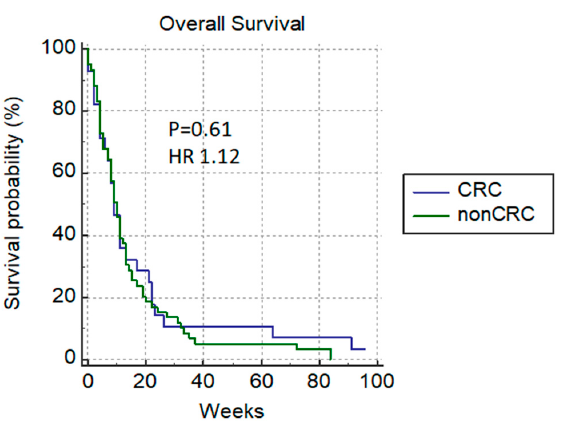
Figure 5. Overall survival of patients with colorectal versus non-colorectal cancer. In a group of patients with poor ECOG, only one patient (1/2) with pancreatic cancer received chemotherapy (Table 2). Table 2. Candidates for chemotherapy after PTBD.